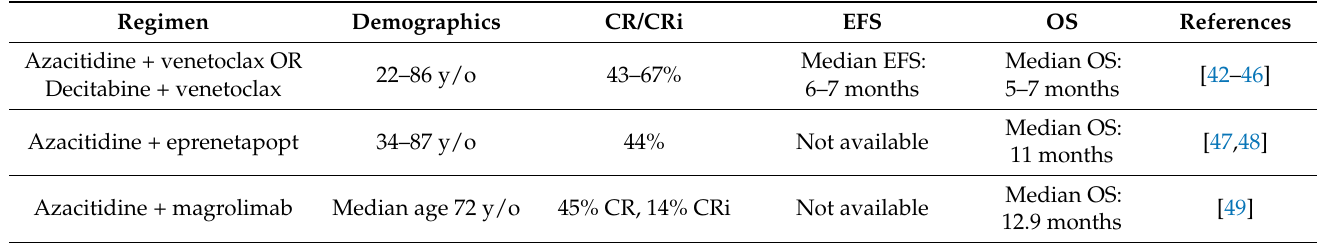
Table 3. Outcome of TP53 -mutated myeloid malignancy patients treated with a combination of hypomethymating agents. CR: Complete Remission, CRi: Complete Remission with Incomplete count recovery, EFS: Event Free Survival, OS: Overall